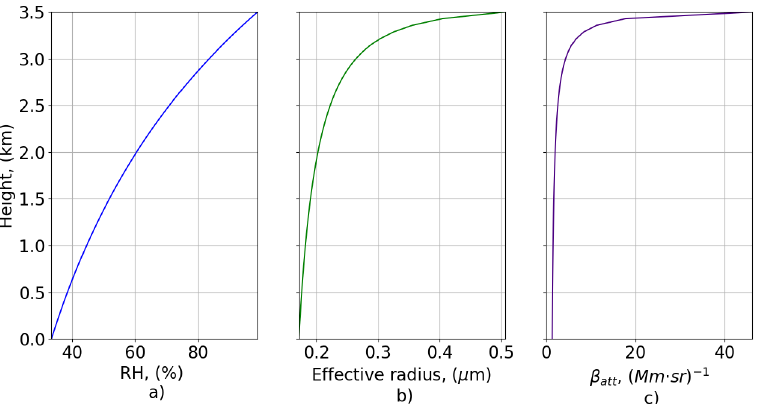
Figure 2. ( a ) Relative humidity (RH), ( b ) effective radius and attenuated backscatter coefficient ( β att ) ( c ) profiles retrieved using LARSS with standard atmospheric conditions at surface (298.15 K, 101.325 kPa, and RH =